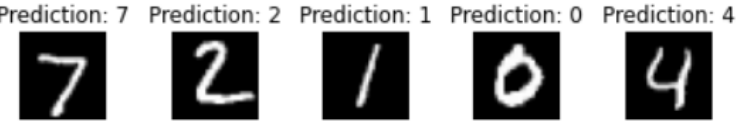
Figure 2. MNIST test dataset predictions.